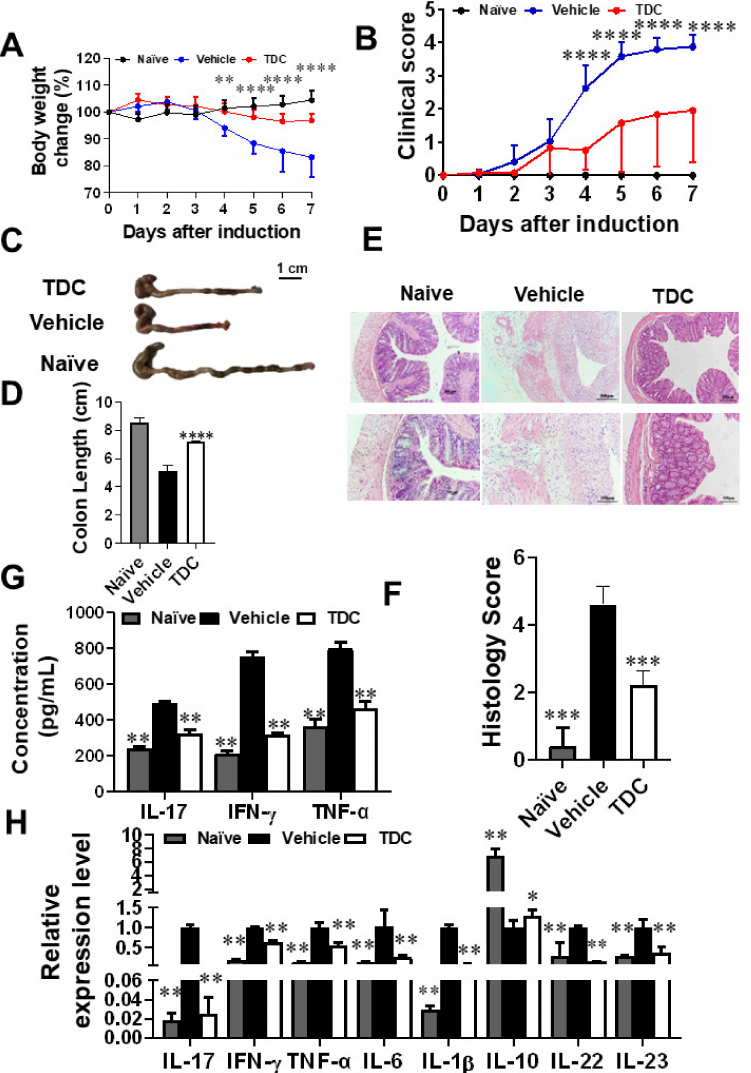
Figure 4. DSS-induced colitis was relieved by TDC. ( A ) The mouse body weight was measured every day during the experiment. ( B ) Clinical score of colitis. ( C , D ) Colon length of mice ( n = 6 each group), scale bar = 1 cm. ( E , F ) H&E staining of colonic tissues in the three groups, scale bar = 200 µ m (upper row) or 100 µ m (lower row). ( G ) ELISA assay was used to detect the secretion of IL-17, IL-6, and TNF- α in mouse colon ( n = 6 per group) ( H ) qRT-PCR was carried out to test the proinflammatory genes in the colitis colon tissues of TDC and vehicle-treated groups. Data are shown as mean ± SD ( n = 3 each group). * p < 0.05, ** p < 0.01, *** p < 0.001, **** p < 0.0001, one-way ANOVA with Tukey’s multiple comparisons test ( D , F – H ), two-way ANOVA with multiple comparisons test ( A , B